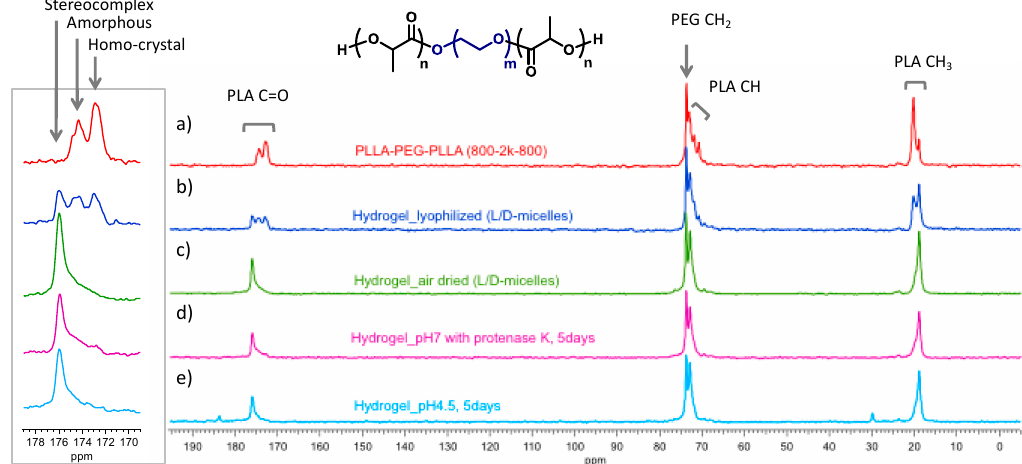
Figure 11. Solid-state 13 C NMR spectra of ( a ) the PLLA-PEG-PLLA polymer, and hydrogels from L- and D-micelles with ( b ) rapid and ( c ) slow dehydration process, and hydrogels after 5 days degradation tests at (d) pH 7 and (e) pH 4.5.